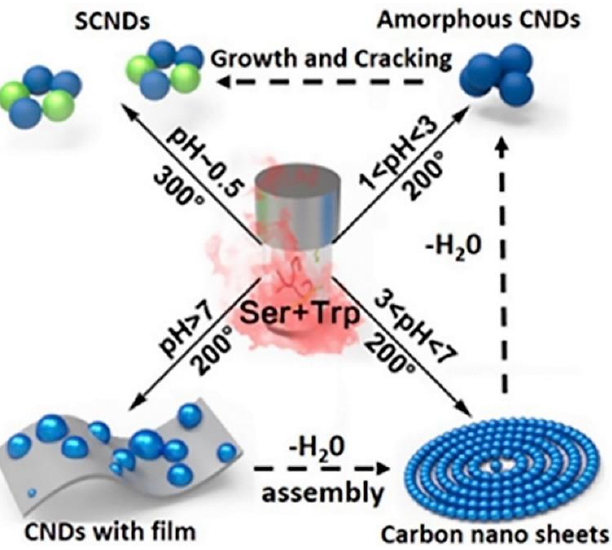
Figure 16. A schematic illustration of the preparation procedure of different structure carbon dots by hydrothermal carbonization of L-serine and L-tryptophan (Ser + Trp) at different pH values and temperatures. (Reprinted from [126]; with the permission of the American Chemical Society).